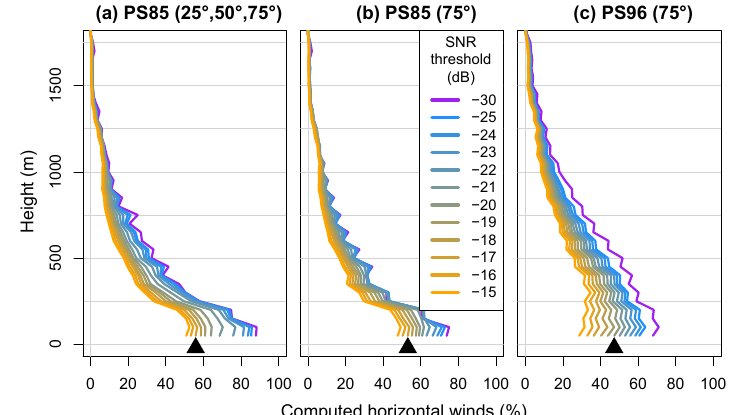
Figure 4. Percentage of wind calculations (speed and direction) from VAD scans as a function of SNR threshold at different heights during PS85 using all elevations (a) , only an elevation of 75 ◦ (b) and PS96 (c) . The total number of VADs for PS85/PS96 was 3552/4250. The black triangle indicates the chosen SNR threshold based on Fig. 5. For the height between 0 and 1750m this chosen threshold results in 15% (PS85, all elevations), 14% (PS85, only 75 ◦ ) or 21% (PS96) of computed horizontal